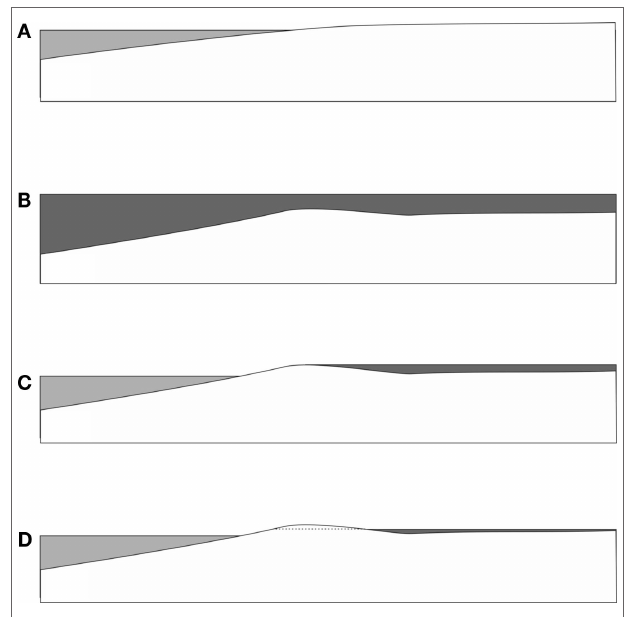
FIGURE 10 | Possible scenario for flooding of a littoral area during a storm event . (A) Before the event. (B) During the storm, wide areas are flooded with water carrying large amounts of sediment and microbes (dark gray) from the sea floor areas. A shallow barrier of accumulated sediment emerges. (C) After the event, the flooded areas remain covered with extended lagoons, due to sediment barriers close to the shore. Microbes have time to settle down and form thick films on the bedding plane. (D) As the flood drains through gaps in the sedimental barrier, the water moves with an increasing flow velocity. As this reaches appreciable values, the hydrodynamic instability sets in, forming Kinneyia ripples.